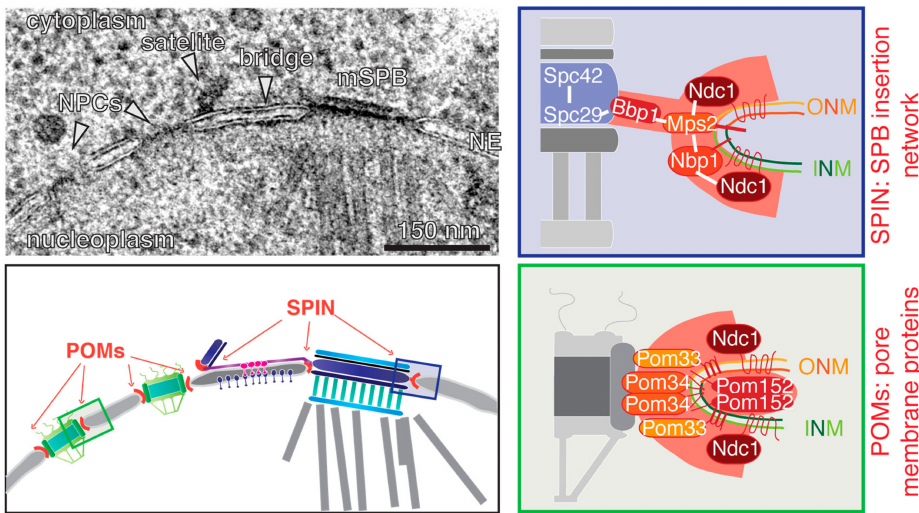
Figure 3. SPB and NPC anchorage complexes. In the top left an EM micrograph is showing a mother SPB (mSPB) and a satellite connected via the bridge. Two NPCs are identified adjacent to the satellite. The corresponding illustration underneath also indicates where the pore membrane proteins (POMs) and SPB insertion network (SPIN) are located; the close-ups on the right list the known components and interactions ( white line